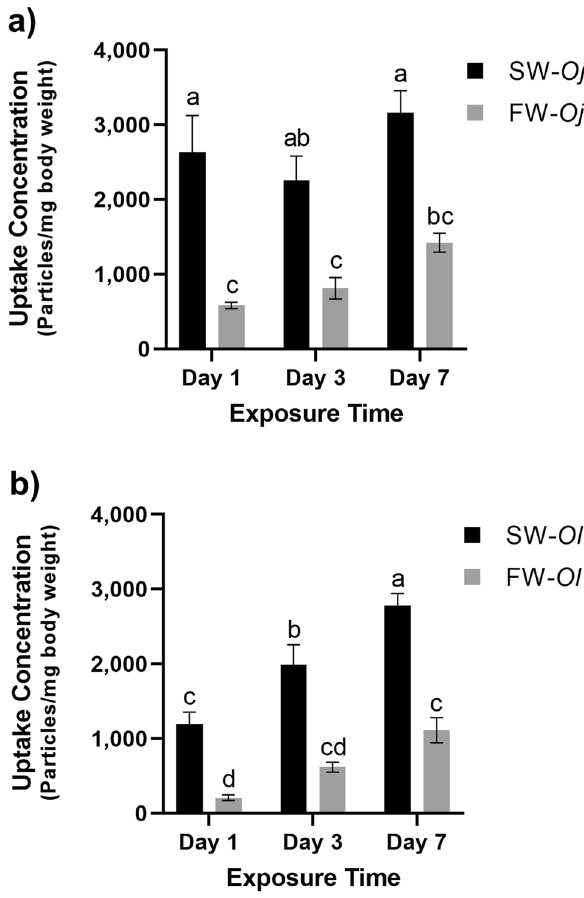
Figure 3. Microplastic uptake in medaka larvae. ( a ) Oryzias javanicus ( Oj ), ( b ) O. latipes ( Ol ). Larvae were exposed to microplastics (0.25 mg/L) for 1, 3, or 7 days. The black bar (SW- Oj , SW- Ol ) indicates uptake concentrations in seawater groups, whereas the grey bar (FW- Oj , FW- Ol ) shows uptake concentrations in freshwater groups. Each bar represents the mean of uptake concentration ± standard error of the mean (SEM). Different letters above the bars indicate significant differences, which were analyzed using one-way analysis of variance (ANOVA) (P < 0.05) followed by Tukey’s Honestly Significant Difference post-hoc